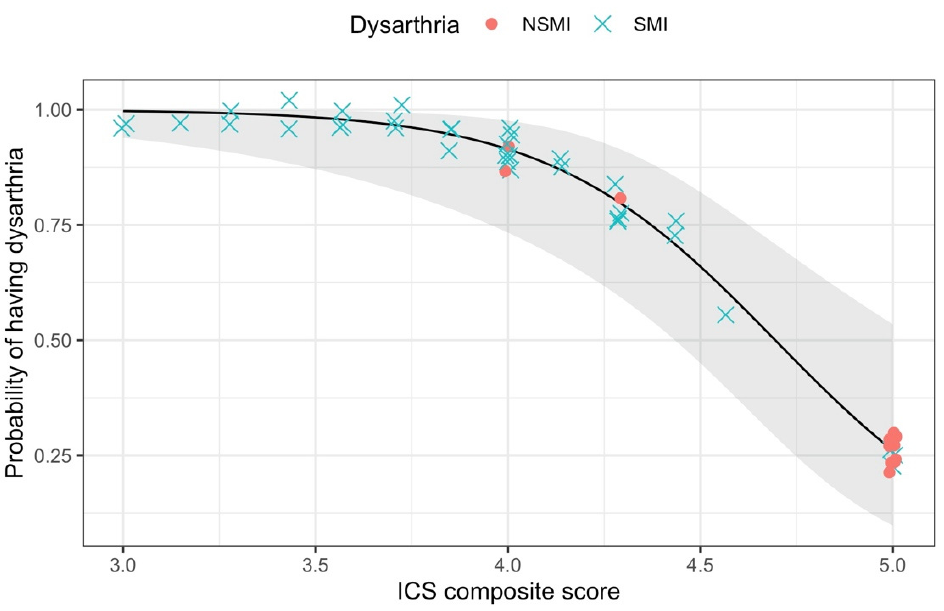
Figure 3. Probability of having SMI given specific ICS composite scores based on the logistic model of presence of SMI as a function of ICS composite score with actual data points from participants. NSMI = No clinical speech motor impairment. SMI = Speech motor impairment.